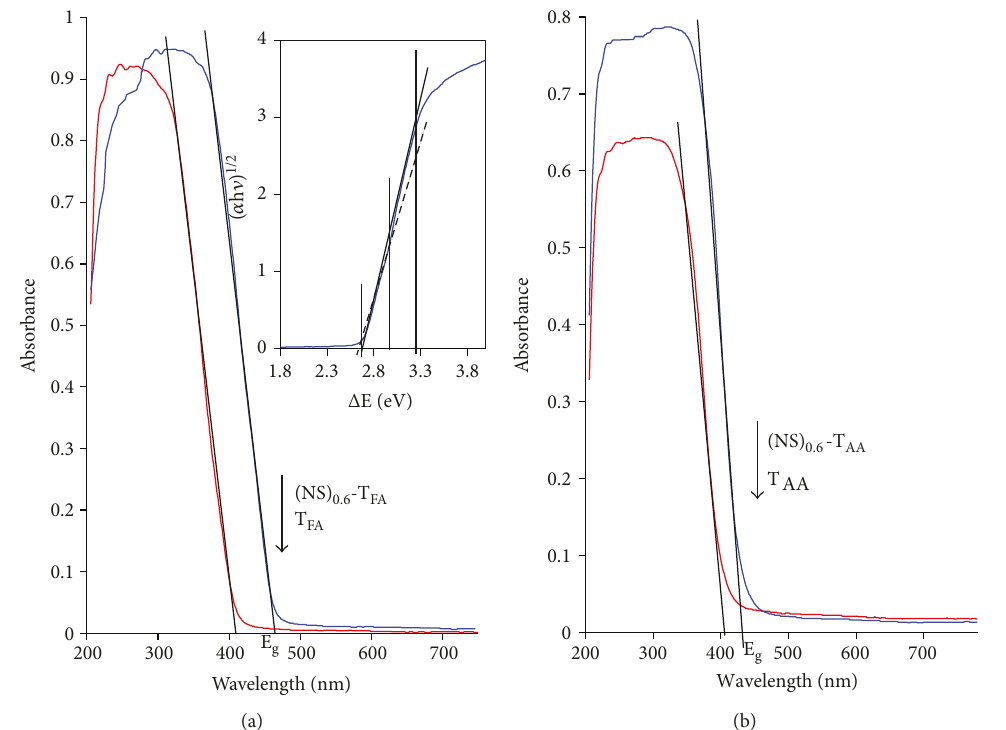
Figure 7: UV-vis DRS absorption spectra of (a) T (NS) -T powders were calcined at 700 ° 0.06 AA